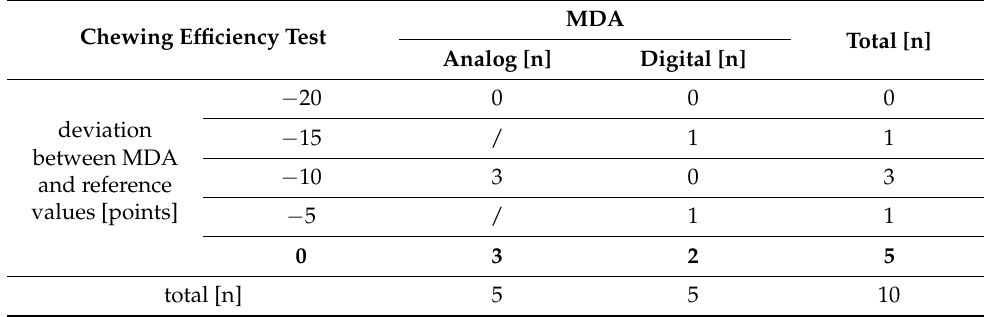
Table 2. Results for the “chewing efficiency test”—deviation between the MDA and reference values for the analog (n = 5) and digital (n = 5) MDA. The absence of deviation from the reference value is shown in bold